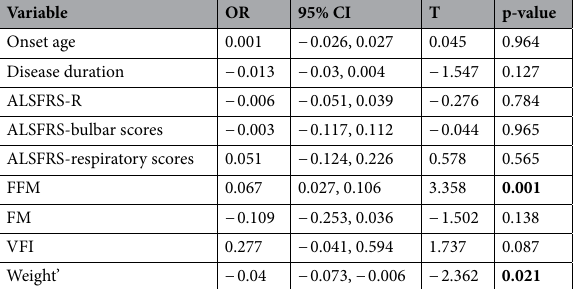
Table 4. Multivariate linear regression analysis of disease progression rate during follow-ups (n = 83). ALSFRS-R revised ALS Functional Rating Scale, FFM fat-free mass, FM fat mass, VFI visceral fat index, Weight’ weight at follow-ups. P-value < 0.05 is shown in